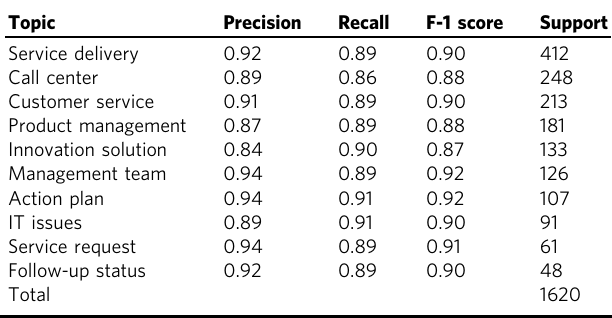
Table 2 Classi fi cation accuracy of the top 10 negative